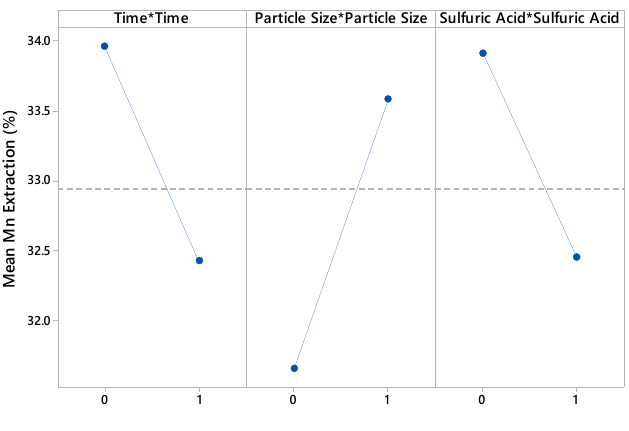
Figure 3. Curvature effect plot for Mn extraction.